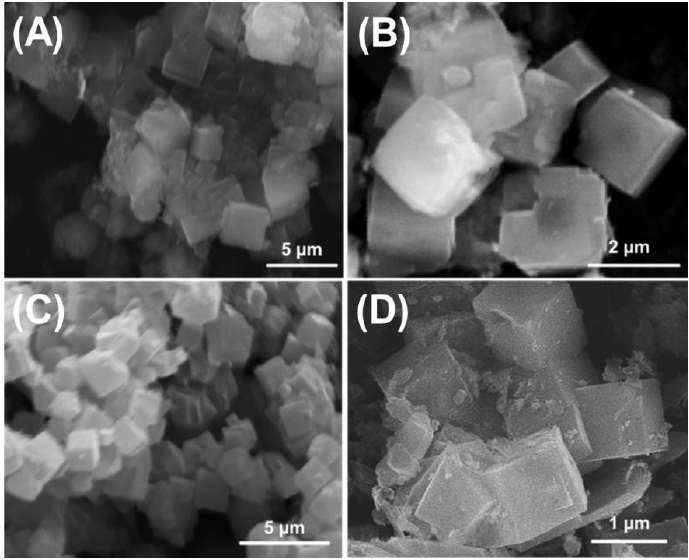
Figure 3. SEM images of the synthetic zeolite-A obtained by conventional method (hydrated zeolite) ( A , B ) and synthetic zeolite-A obtained by alkali fusion method (dehydrated zeolite) ( C , D ). The differences between the two forms of synthetic LTA zeolite in their structural, morphological, and chemical properties are associated with significant changes in their textural properties. The determined surface area of H.ZA and DH.ZA is 423 m 2 /g and 488 m 2 /g, respectively (Table 1). Such values are in agreement with the obtained findings of the morphological and particle size distribution results. Additionally, the DH.ZA shows a higher pore volume (0.446 cm 3 /g) and lower pore diameter (9.2 nm) than the determined values for H.ZA (0.446 cm 3 /g pore volume and 11.6 nm pore diameter), which are also essential factors during the evaluation of the products as catalysts (Table